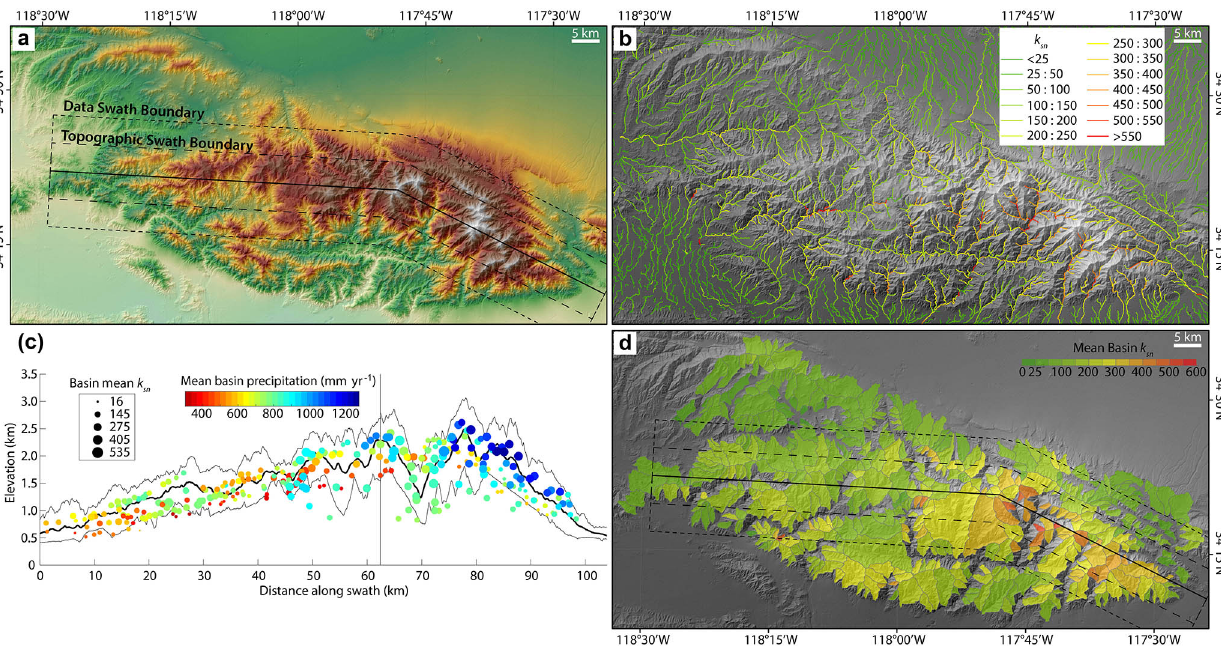
Figure 2. Example products output from TAK (with some compilation in ArcGIS and editing in a graphics program). (a) Shaded elevation map of the San Gabriel Mountains in southern California with outlines of a combined swath profile. (b) Normalized channel steepness map from KsnChiBatch. (c) Swath profile with 10km sampling width for the topography and 20km sampling width for the basin data, basins are located based on their centroid location and mean elevation, colored by their mean annual precipitation averaged from 1981 to 2010 (data from PRISM Climate Group, Oregon State University, http://prism.oregonstate.edu, downloaded: 1 June 2018, last access: 18 January 2019), and scaled by their mean k sn . (d) Map of basin-averaged k sn using “ProcessRiverBasins” and “SubDivideBigBasins” (using the trunk division method and a max basin size of 25km 2